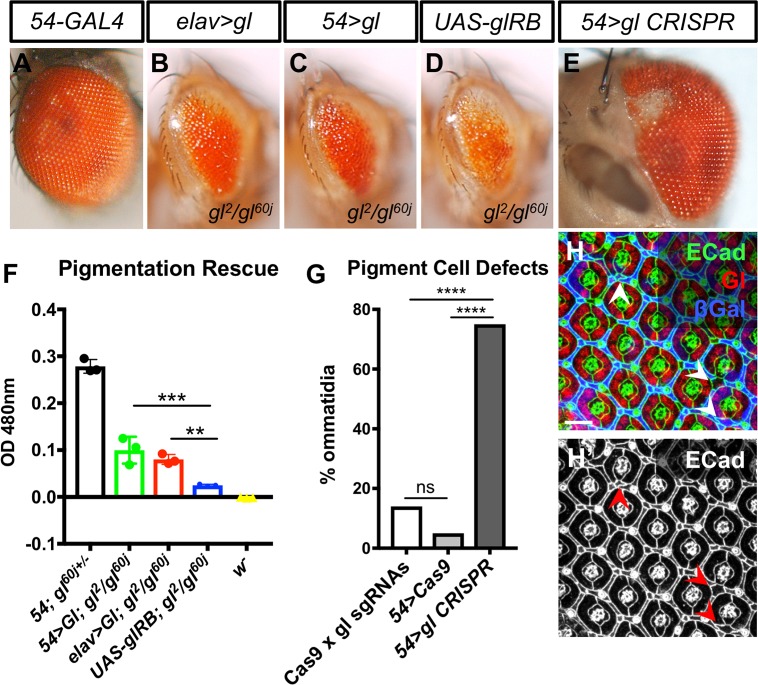
Gl can act autonomously in pigment cells.(A-E) show adult eyes; (A) 54-GAL4, UAS-lacZ; (B) elav-GAL4/UAS-gl, UAS-lacZ; gl2/gl60j; (C) 54-GAL4/UAS-gl, UAS-lacZ; gl2/gl60j; (D) 54-GAL4, UAS-lacZ/+; gl2/gl60j; (E) 54-GAL4/gl sgRNAs; UAS-Cas9P2, gl60j/+. Expressing Gl specifically in neurons or in the precursors of secondary and tertiary pigment cells in a gl mutant background increases the production of eye pigment, while mutating gl in pigment cells causes loss of pigment. (F) shows a quantification of pteridine pigment in the heads of 54-GAL4, UAS-lacZ/+; gl60j/+ controls; 54-GAL4, UAS-lacZ/UAS-gl; gl2/gl60j or elav-GAL4, UAS-lacZ/UAS-gl; gl2/gl60j rescued flies; UAS-gl, UAS-lacZ/+; gl2/gl60j
gl mutants; and w1118 flies. **p<0.005, ***p<0.0001, unpaired two tailed t-test. (G) shows a quantification of ommatidial patterning defects when UAS-Cas9 and gl sgRNAs are present with no GAL4 driver (n = 295) or when Cas9 is expressed in pigment cells in the presence (n = 154) or absence (n = 226) of gl sgRNAs. ****p<0.0001, ns, not significant, Fisher’s exact test. (H) 42h APF 54-GAL4, UAS-Cas9/gl sgRNAs; gl60j/+ pupal retina stained with anti-Ecad (H’, green in H), anti-Gl (red in H), and anti-β-galactosidase reflecting UAS-lacZ driven by 54-GAL4 (blue in H). Examples of defects quantified in (G) are shown (arrows, H’). Scale bar: 10μm.